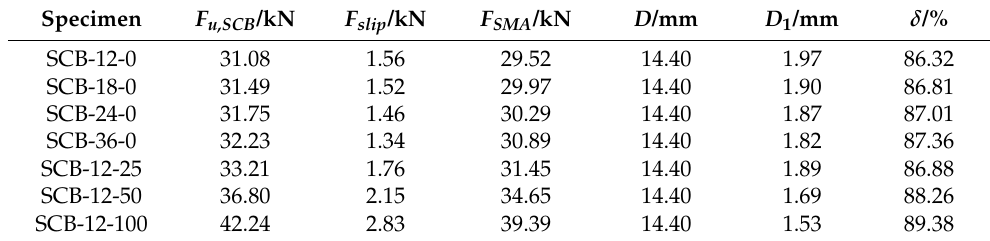
Table 5. Performance indices of self-centering SMA